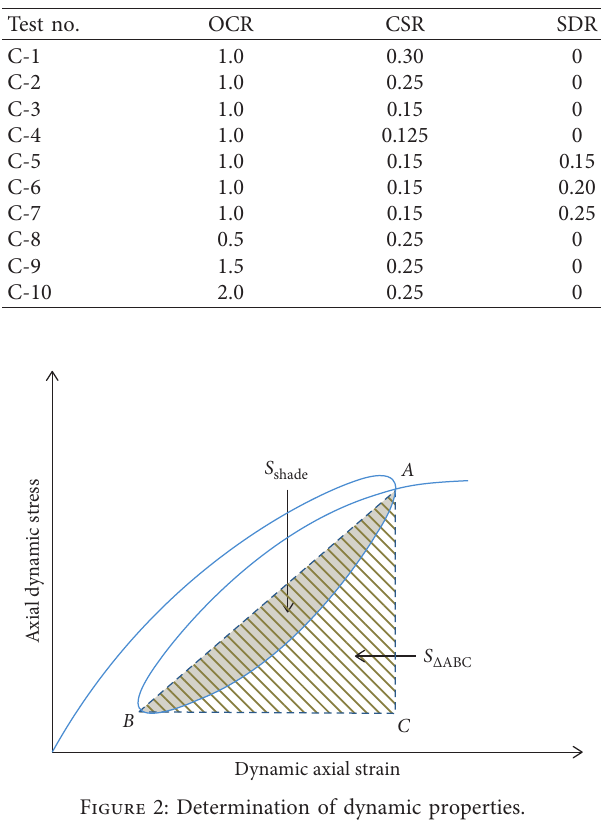
Figure 1: Schematic of the loading time-history curve. Table 2: Dynamic triaxial test scheme.